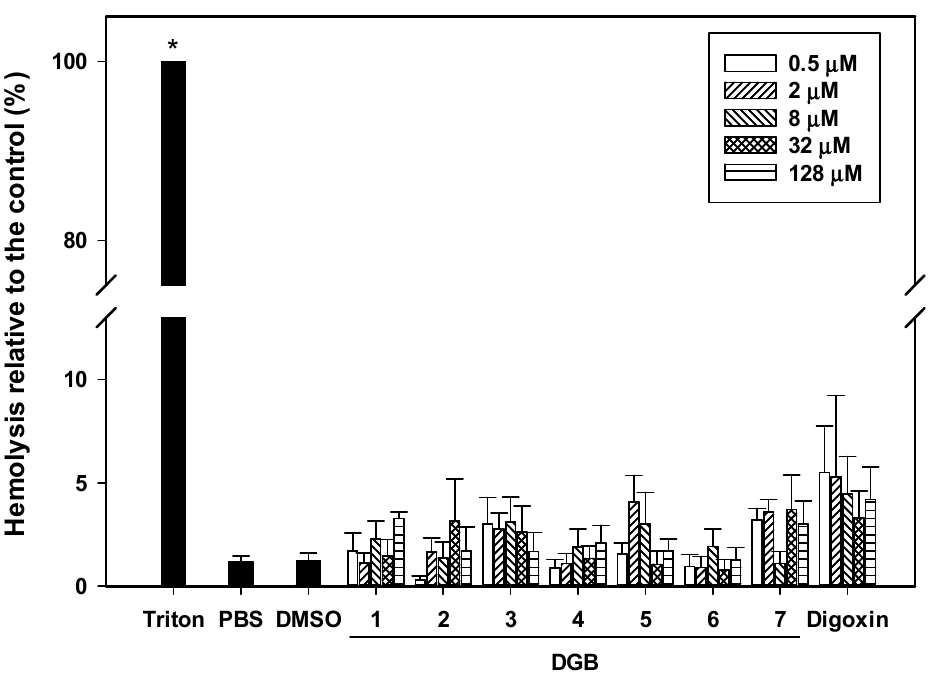
Figure 6. Hemolysis assay: Erythrocytes were incubated in the presence of serial concentrations of digoxin and its derivatives, and the absorbance of released hemoglobin was measured at 540 nm. Triton X-100 and PBS were used as controls of 100% and 0% hemolysis, respectively. DMSO was also used as a control. Data refer to three independent experiments; (*) p < 0.05 in comparison to PBS treatment. DGB 1-7: digoxin derivatives. PBS: phosphate-buffered saline. DMSO: dimethyl sulfoxide.